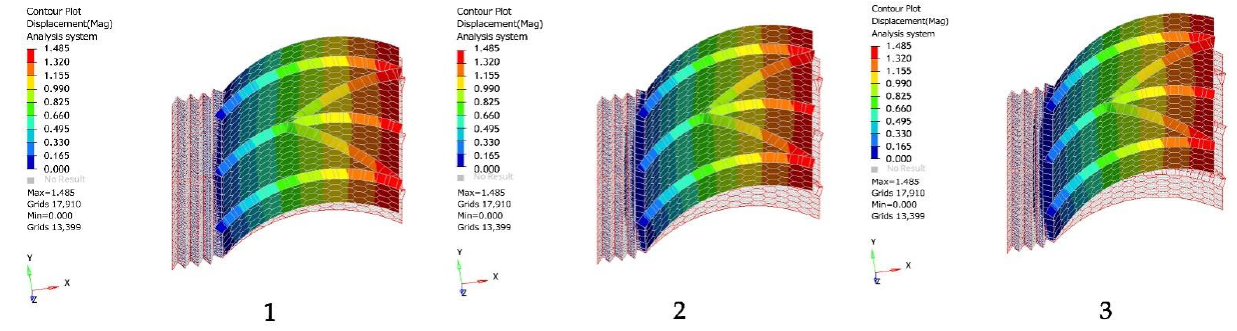
Figure 8. Deformation of ceiling under lateral load.1 is the initial roof lateral deformation, 2 is the intermediate roof lateral deformation, and 3 is the severe roof lateral deformation.